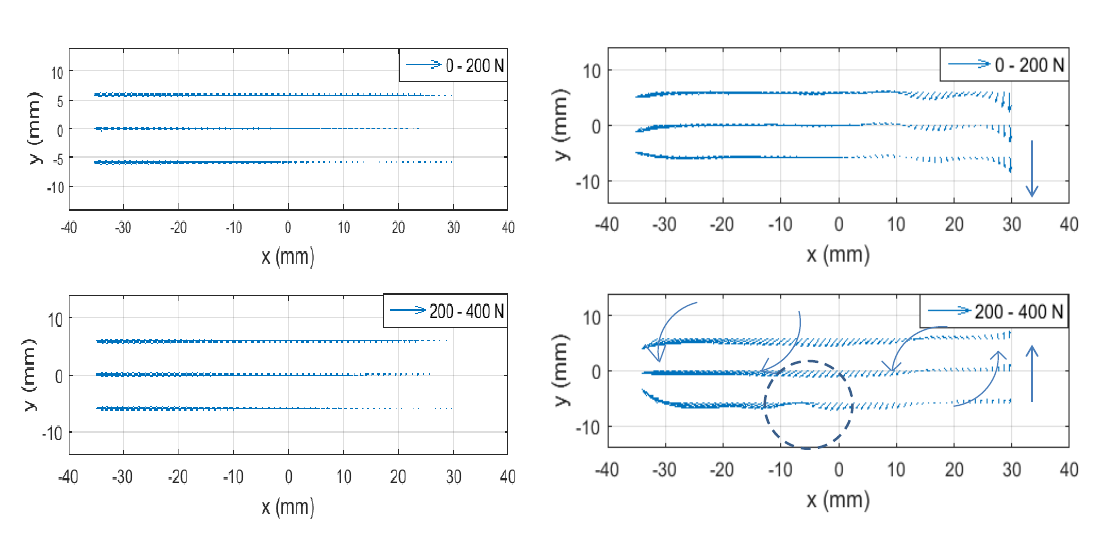
Figure 9. Velocity field 0–200 N ( top ) and 200–400 N ( bottom ). In the right figure, the vertical component of velocity is multiplied by a factor of 500 for better visibility of rotational